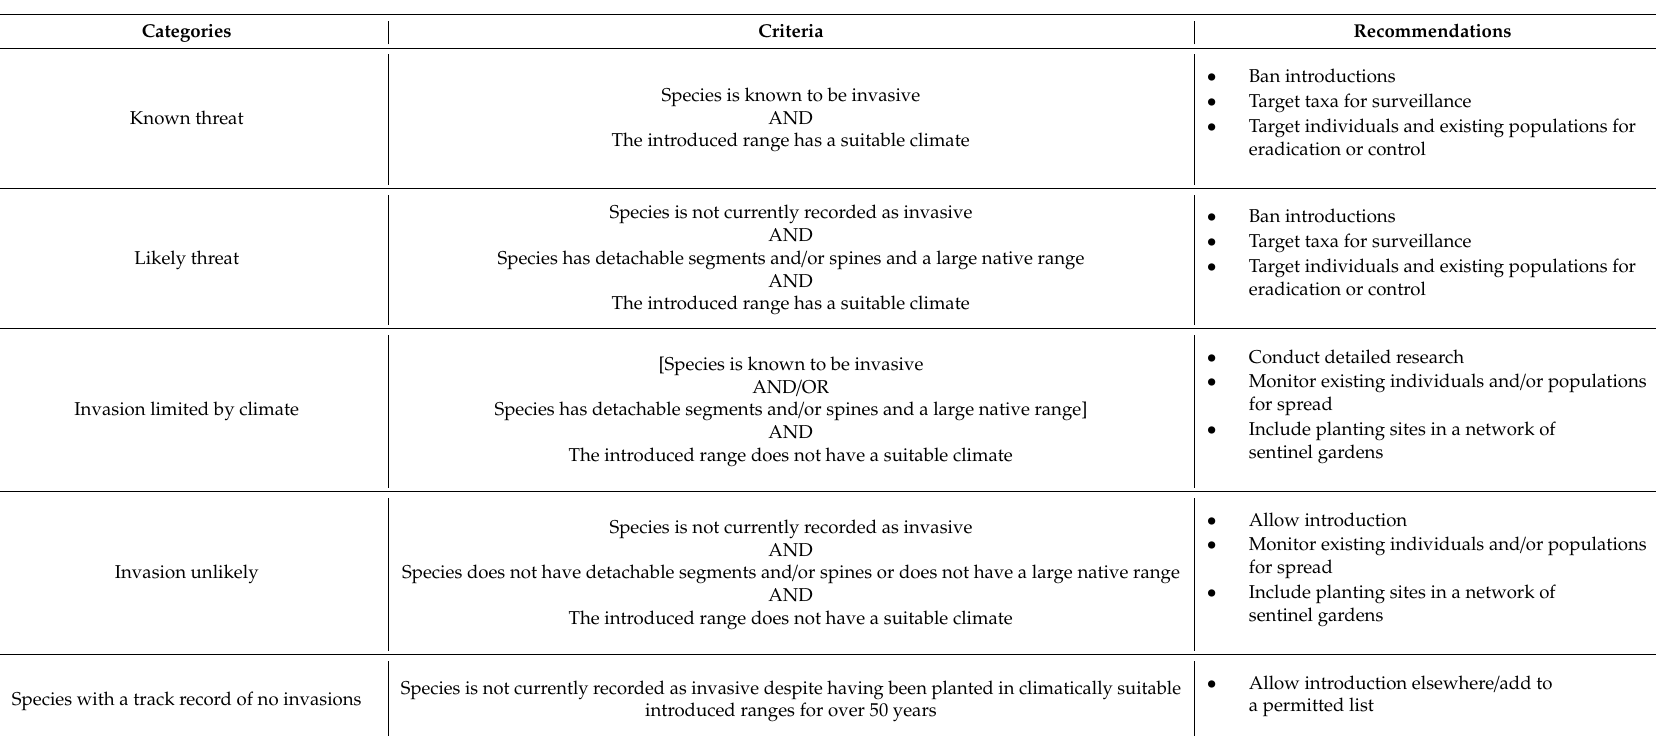
Table 1. Proposed scheme for categorising cactus species based on the risks that they will become invasive and cause negative impacts in a given introduced range (based on an approach developed for Australian acacias